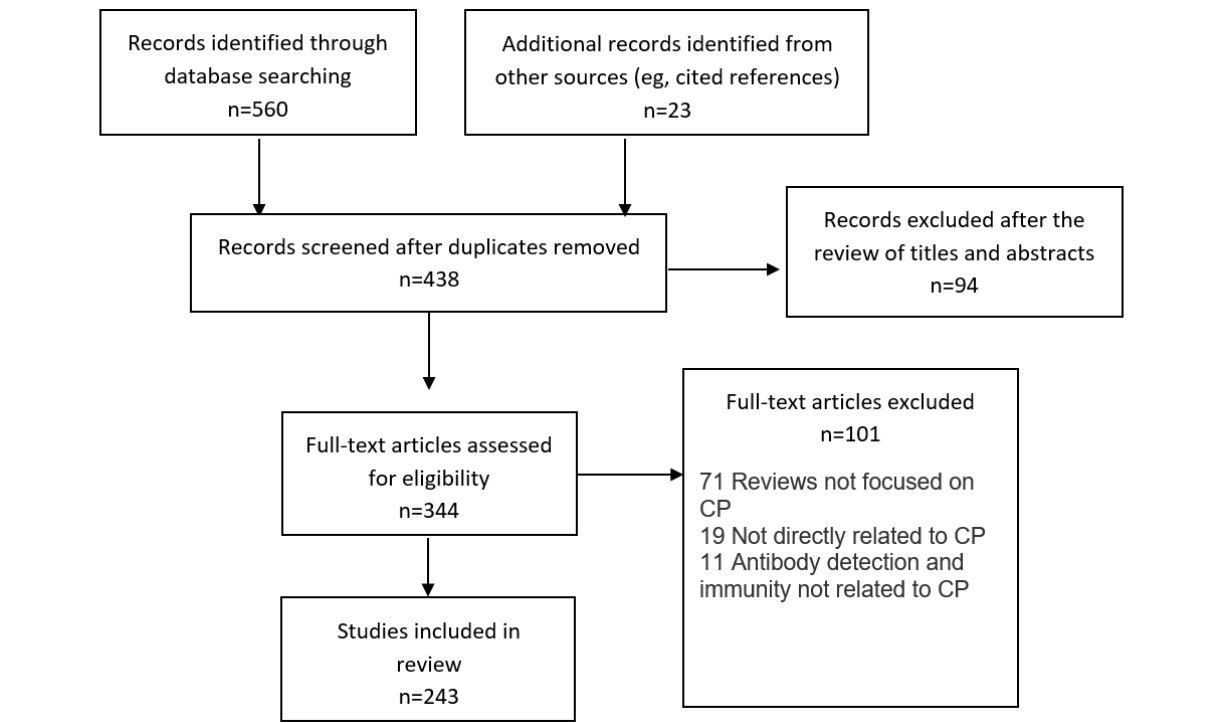
Figure 1. PRISMA (Preferred Reporting Items for Systematic Reviews and Meta-Analyses) flow diagram. The literature search was conducted on June 19 and updated on October 22, 2020. The screening, full-text review, and extraction were managed online using Covidence. CP: convalscent